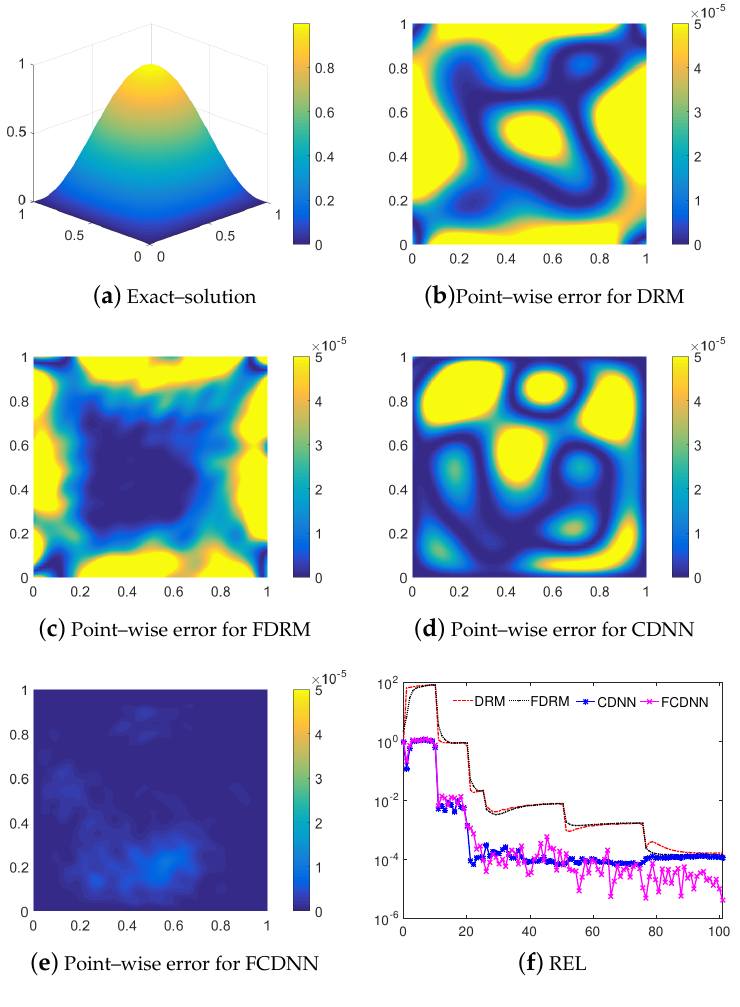
Figure 4. Testing results for Example 2. Table 1. REL and running time of the aforementioned four models for Example